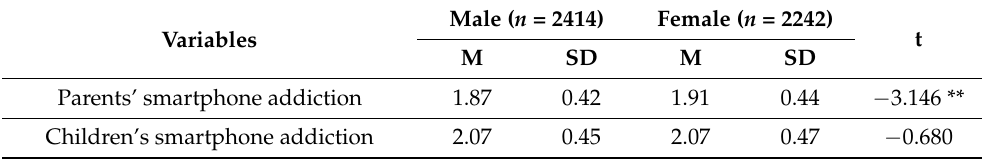
Table 3. Differences in the main variables by children’s gender.